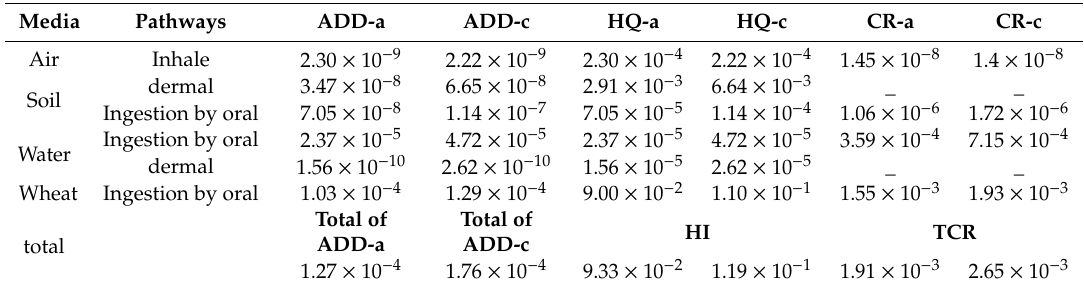
Table 3. Exposure to different media, non-carcinogenic risk, and carcinogenic risk (-a for adult, -c for children).